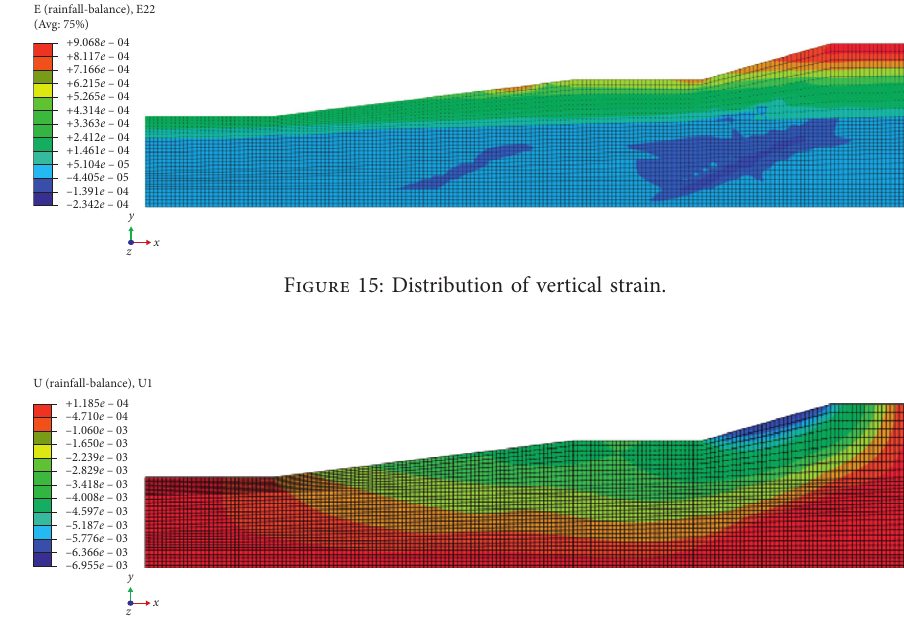
Figure 16: Distribution of horizontal